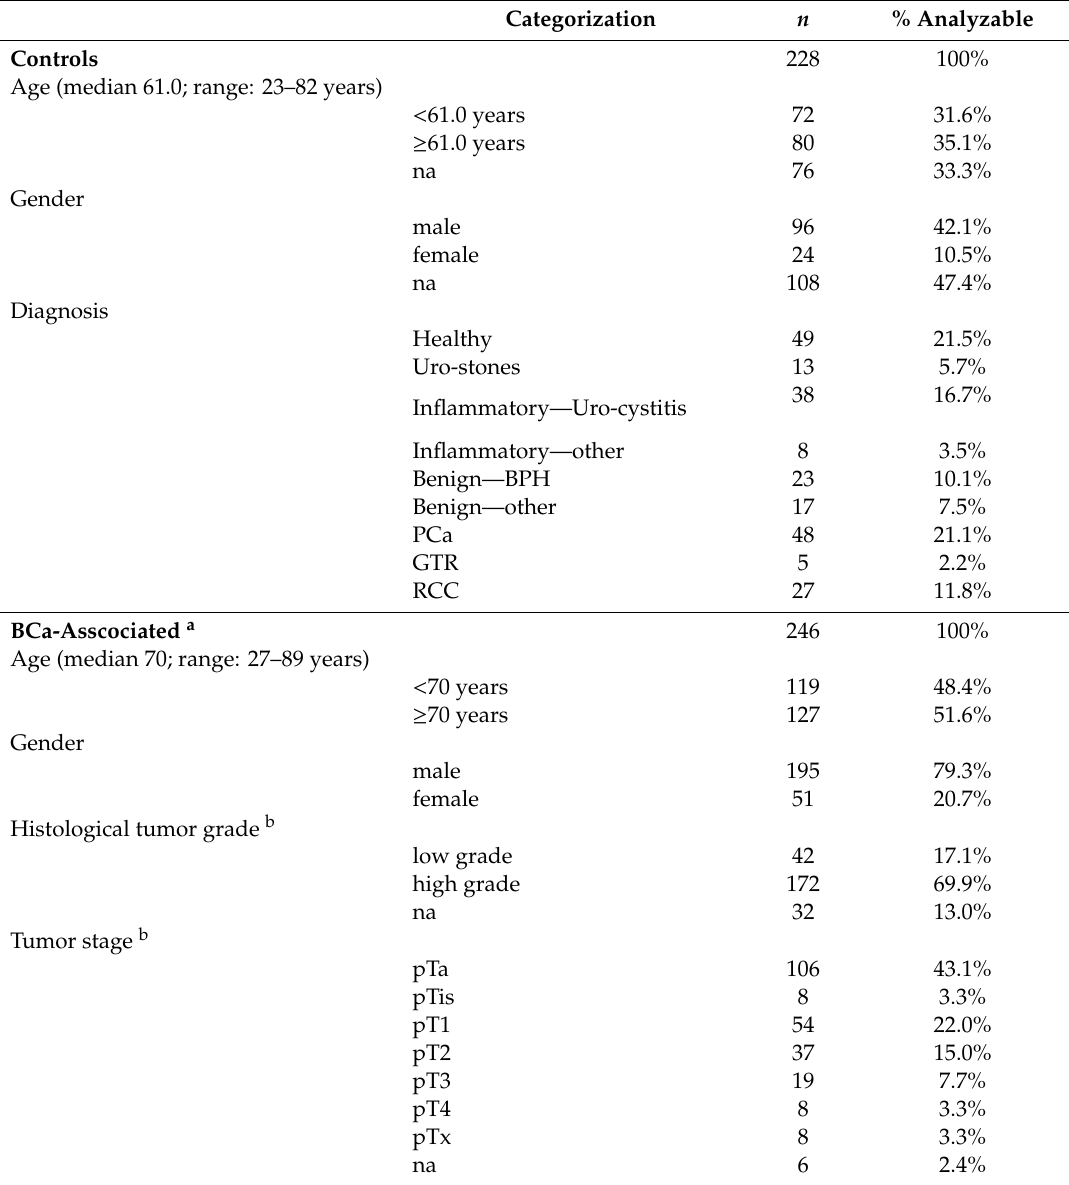
Table 5. The clinico-pathological parameters of 474 patients whose urine samples were analyzed in this study. Categorization n % Analyzable Controls 228